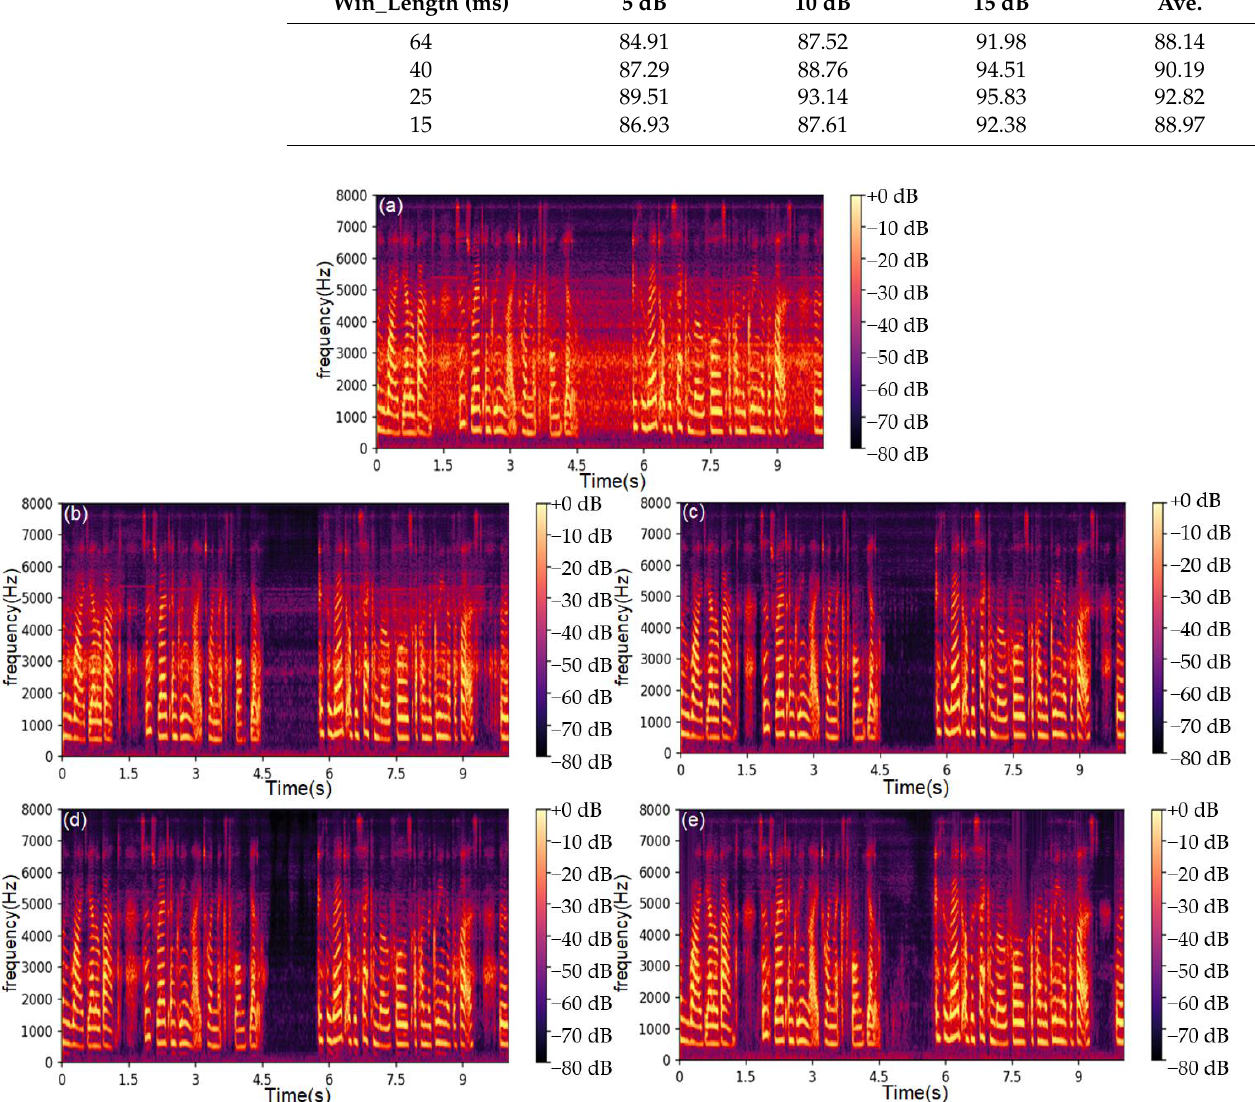
Figure 7. Test results of models with different window lengths: ( a ) STFT spectrogram of original speech signal, ( b ) model with a window length of 15 ms, ( c ) model with a window length of 25 ms, ( d ) model with a window length of 40 ms, ( e ) model with a window length of 64 ms.